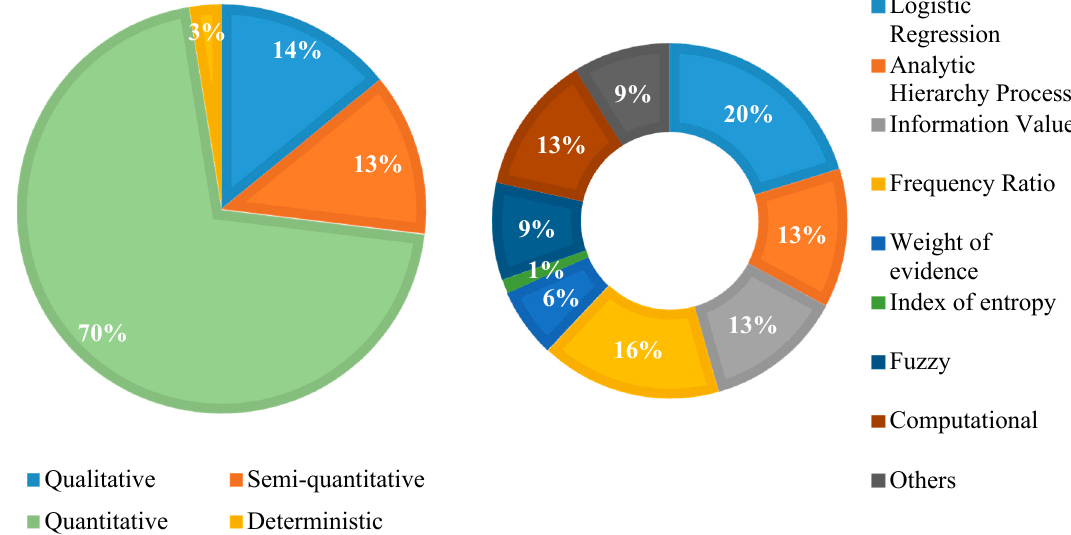
Figure 8. Model types and the techniques used in hazard and susceptibility studies.